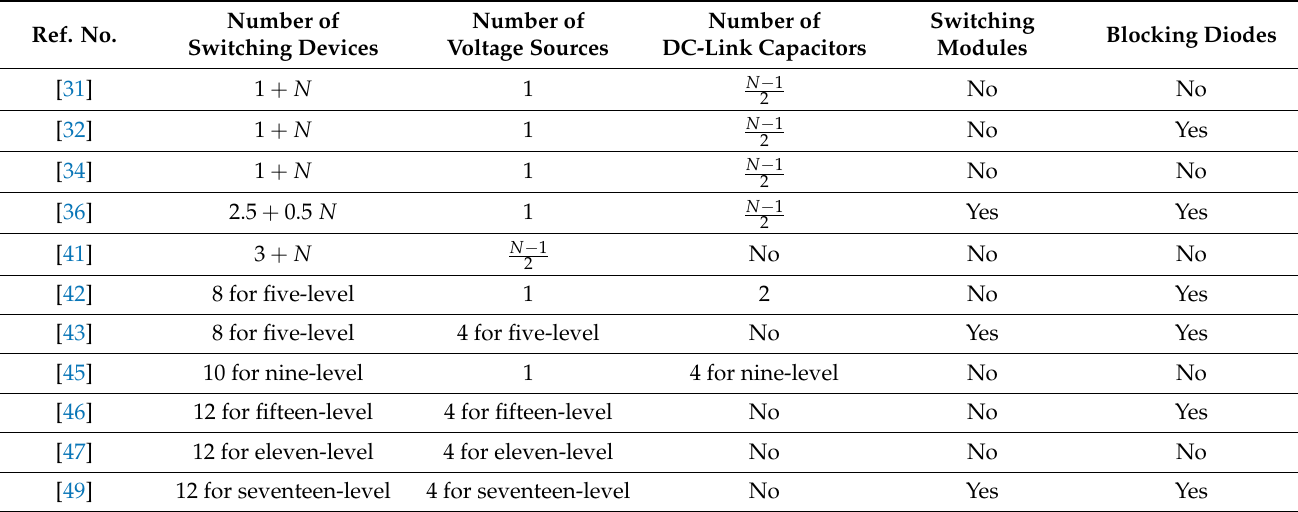
Table 2. Comparison between different T-Type MLI